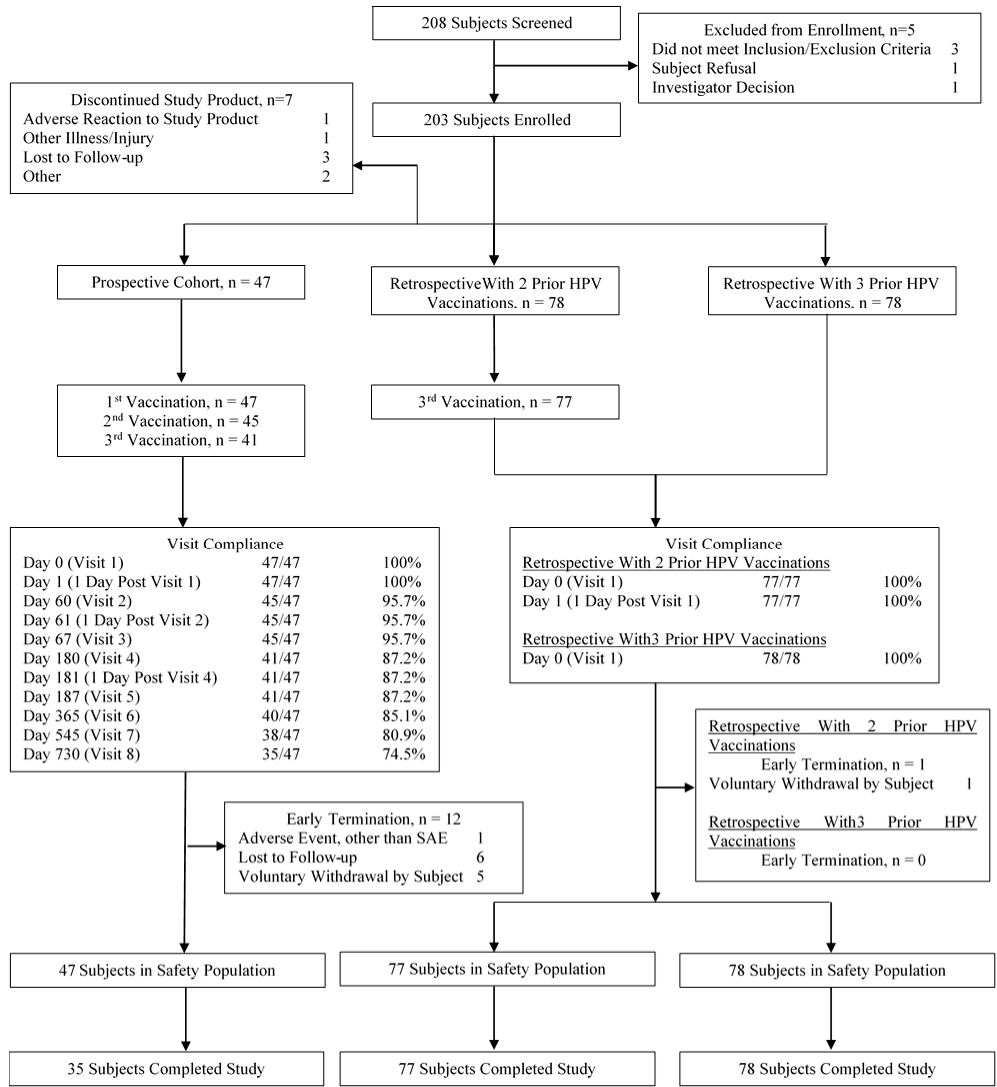
Figure 1. Disposition of study subjects-consort flow diagram. n: the number of subjects.